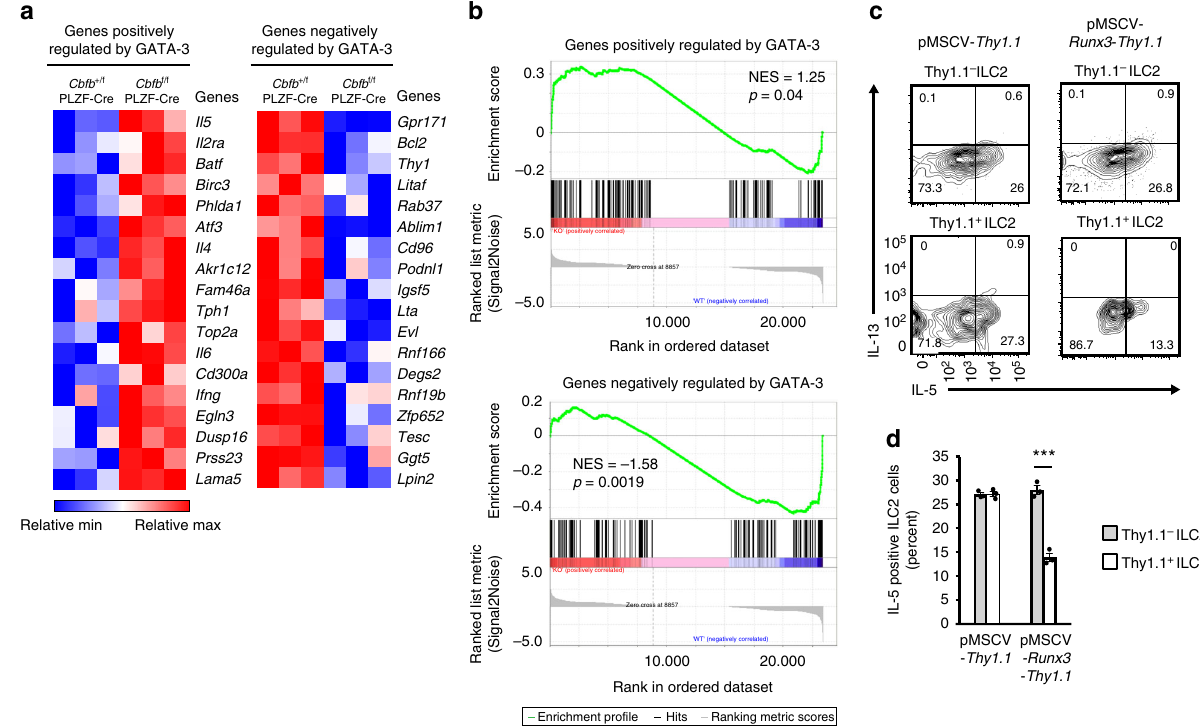
Fig. 3 Runx proteins inhibit the gene expression regulated by GATA-3 in ILC2s at steady state. a Heat map of the expression of selected genes positively (left) or negatively (right) regulated by GATA-3 in ILC2s as determined by RNA sequence analysis. b Gene set enrichment analysis of genes positively (top) or negatively regulated by GATA-3 performed on a gene set that was differentially expressed in Cbfb f/f PLZF-Cre ILC2s compared to Cbfb + /f PLZF- Cre ILC2s. c , d Host mice (CD45.1 + ) were lethally irradiated and reconstituted with CD45.2 + bone marrow cells that were retrovirally transduced with the control vector, pMSCV- Thy1.1 (left) or pMSCV- Runx3 - Thy1.1 (right). Flow cytometry analysis of IL-5 and IL-13 expression by untransduced Thy1.1 – (top) or transduced Thy1.1 + (bottom) donor CD45.2 + ILC2s (CD45 + CD3 – CD19 – CD127 + CD25 + KLRG1 + ) from the lungs of the host mice ( c ). The frequency of IL-5-producing cells in the indicated ILC2s was determined by fl ow cytometry as in c ( d ). Numbers in quadrants of the bottom plots indicate the percentages of cells in each quadrant. In d , *** p < 0.001 by Student ’ s t -test. Data are representative of at least two independent experiments (mean ± s.d. of three mice in d